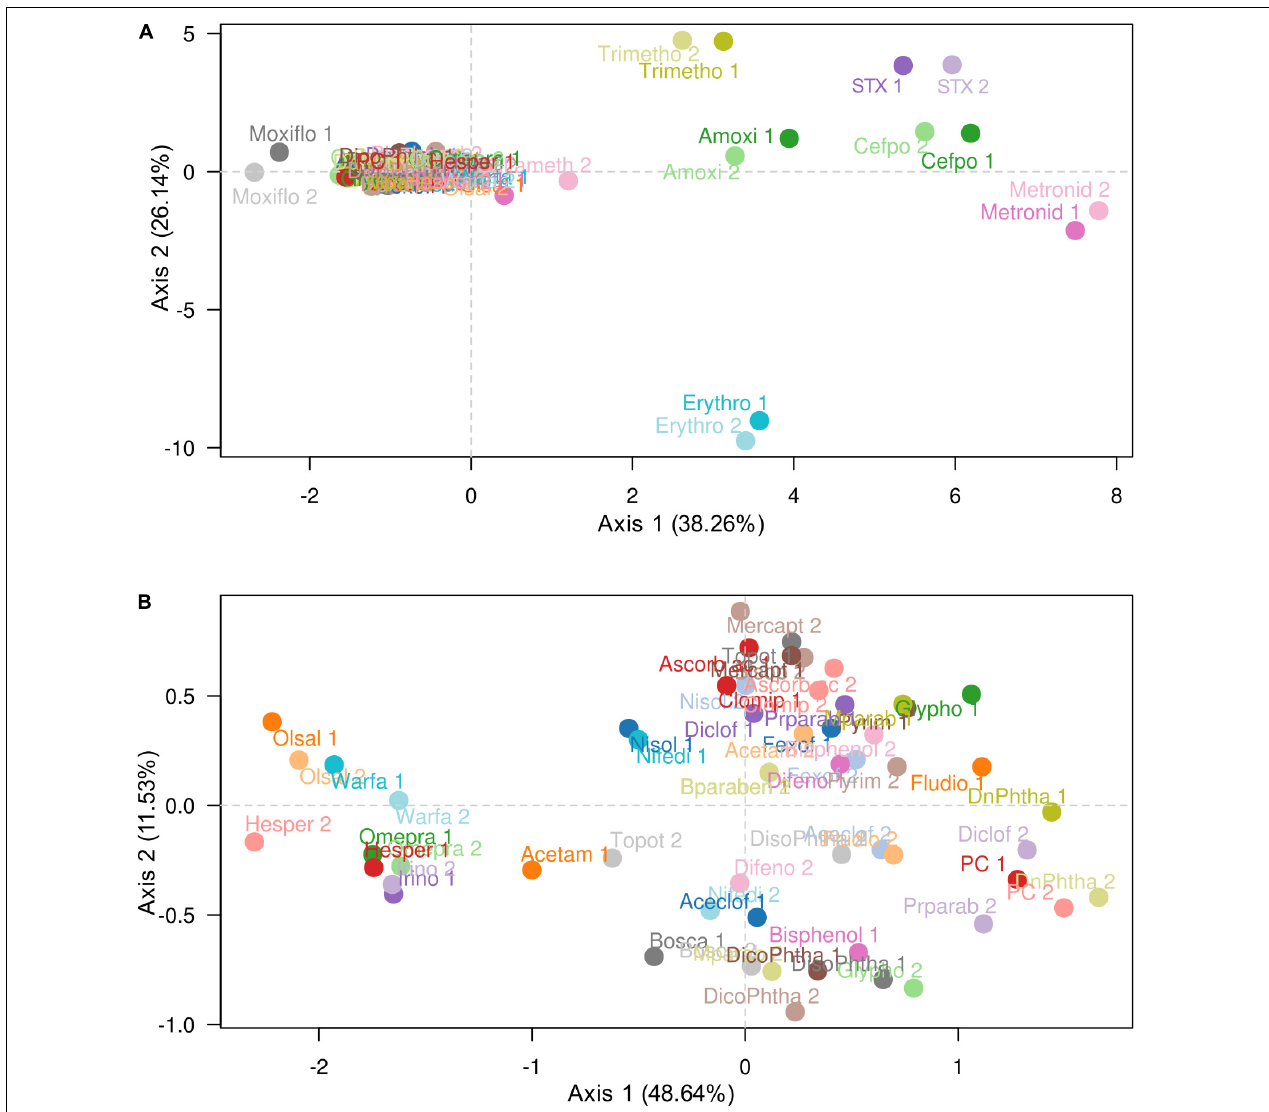
FIGURE 2 | Repartition of the HGMM bacterial community after exposure to antibiotics, drugs and xenobiotics. (A) Principal component analysis based on weighted UniFrac β -diversity metric considering all the antibiotics, drugs and xenobiotics tested in the study. Total variance explained by the two axes was 64.4%. (B) The same analysis excluding the eight antibiotics. Total variance explained by the two axes was 60.1%. Results from two independent replicates analyses are reported for each molecule (written “1” and “2” after the name of the molecule). Antibiotic, drug and xenobiotic abbreviations were mentioned in Table 2